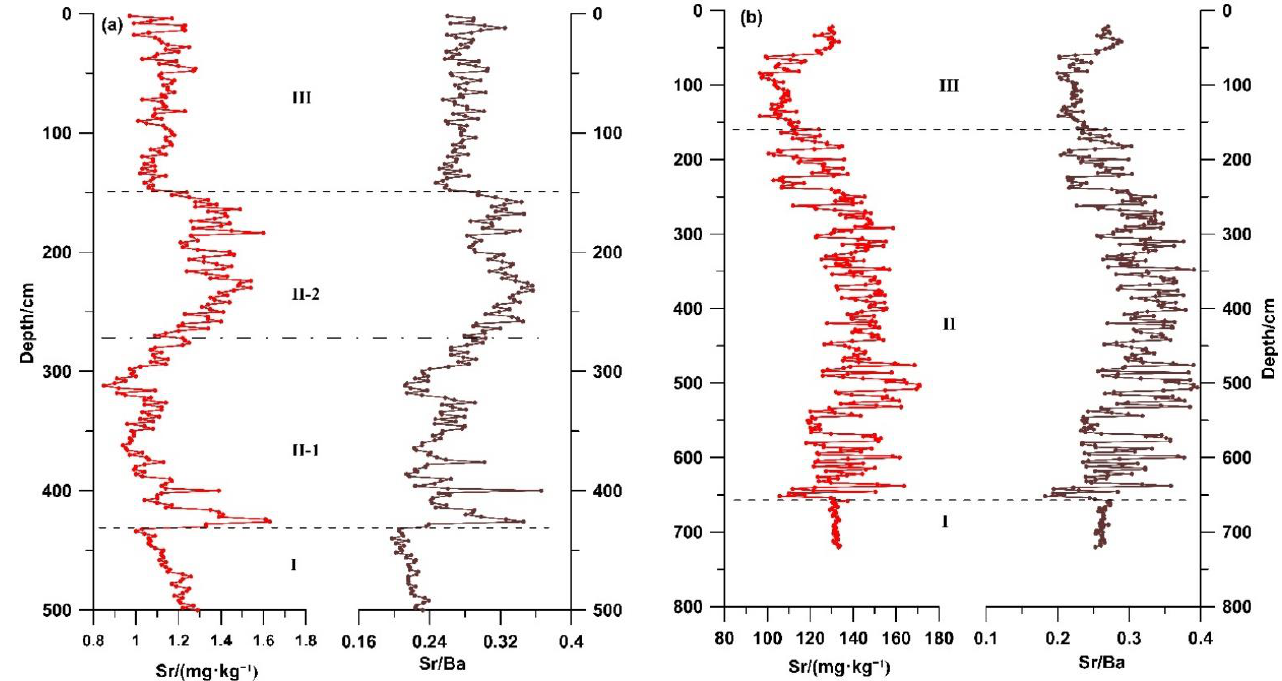
Figure 7. Variation characteristics of Sr and Sr/Ba ratio of sediments in GX ( a ) and CYK ( b ) profiles.